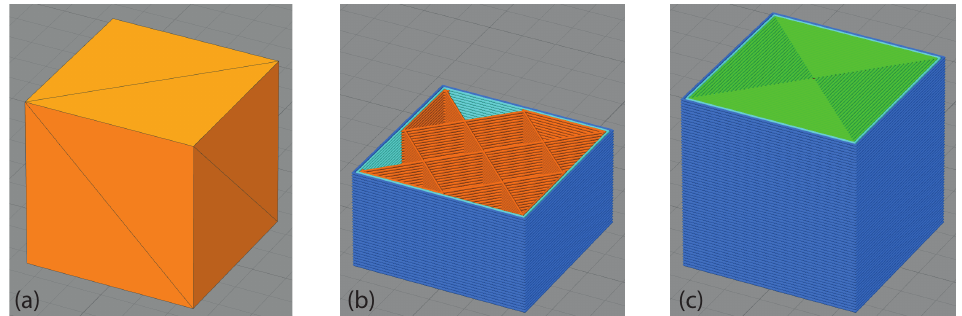
Figure 3. The surface of the geometry is defined with triangles ( a ) in the STL file. The slicer then converts this surface information into a solid geometry and splits the geometry into slices (layers) with an equal layer height and generates the path for the printer according to the settings. The layer consists at least of the outline of the part (so called perimeter) and the infill. Figure ( b ) shows the outer (blue) and the inner (light blue) perimeter and the 10% infill (orange) of the layers. The lowest and the most upper layers are printed solid to close the part (green surface in Figure ( c